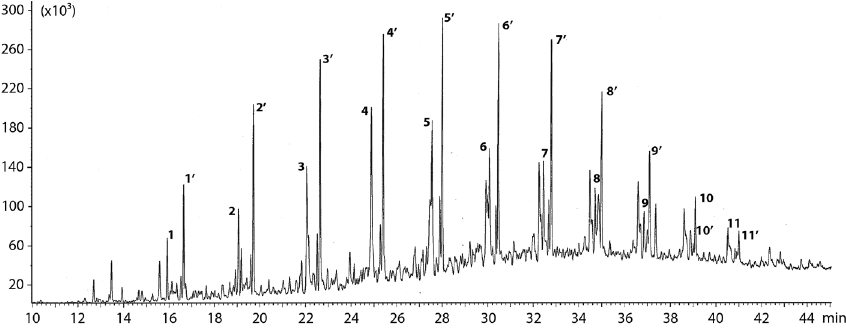
Fig. 7. A GC-MS chromatogram of the polar component of the neutral